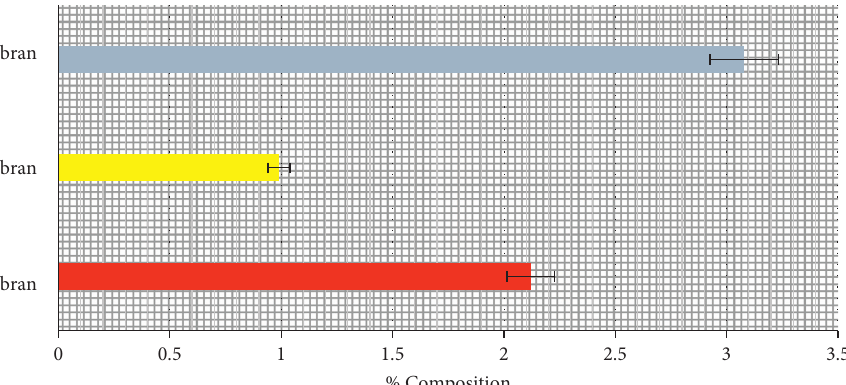
Figure 1: Percentage unrefined lipid content of poultry-mix.